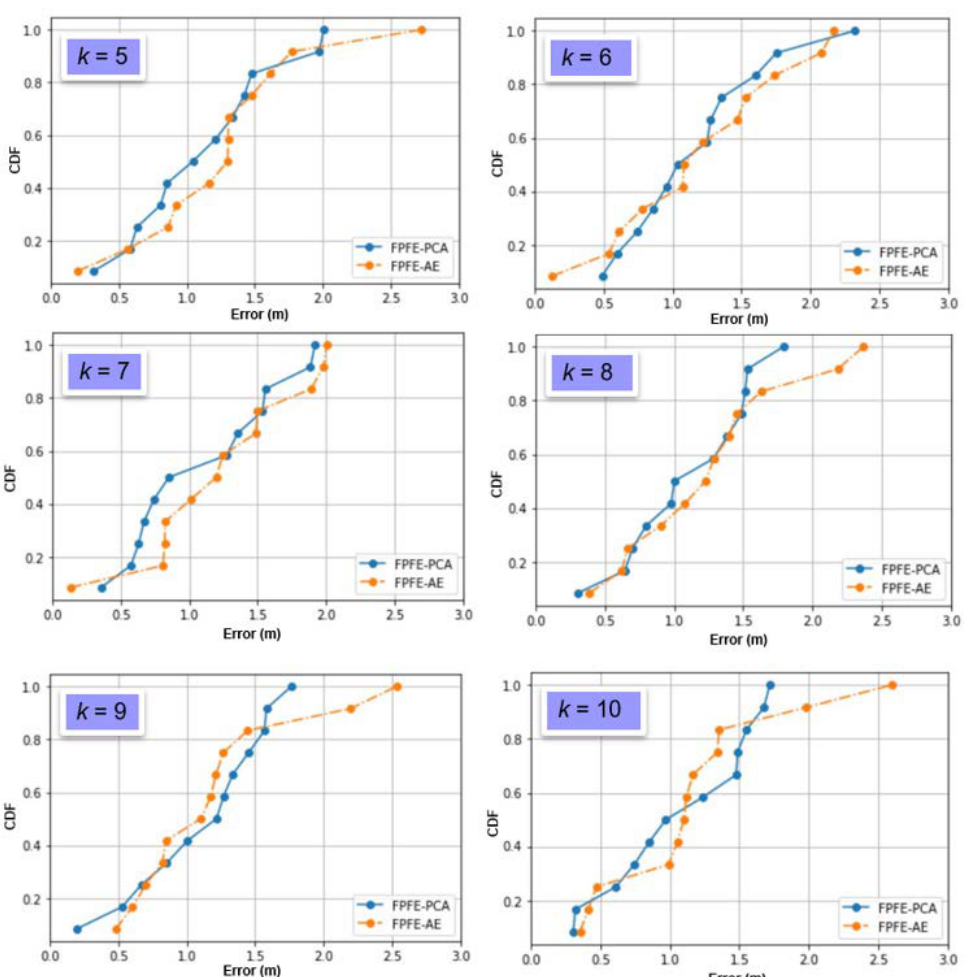
Figure 8. The localization error CDF curves of FPFE with 54 random RPs for k RP candidates, where k = 5, 6, 7, 8, 9, and 10.